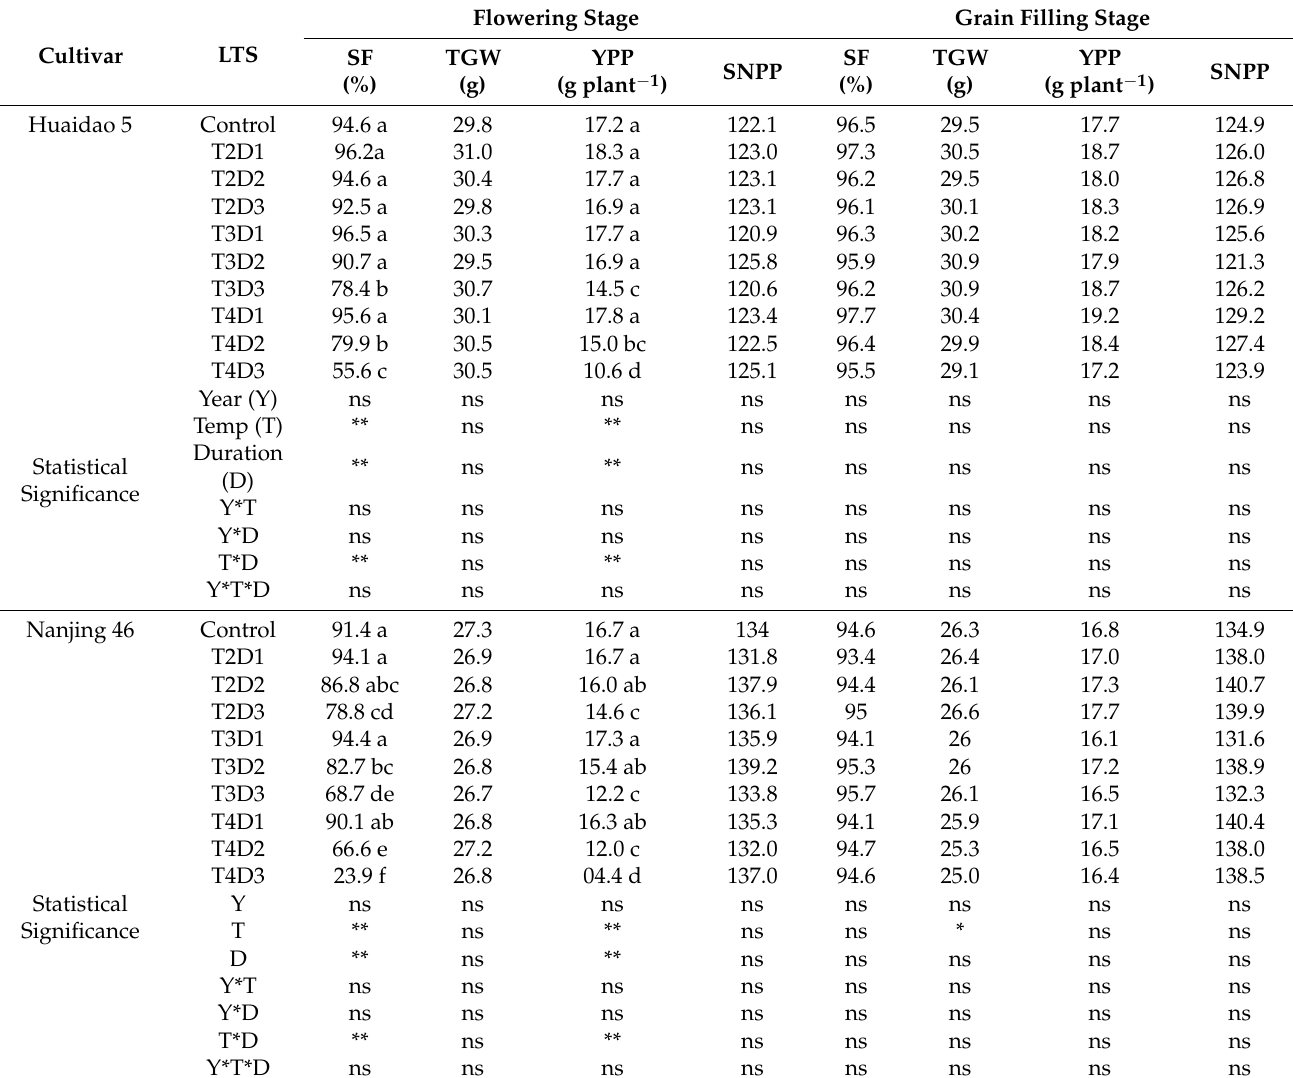
Table 1. Effects of low-temperature stress at flowering and grain filling stages on yield and related parameters over the two-year experiment